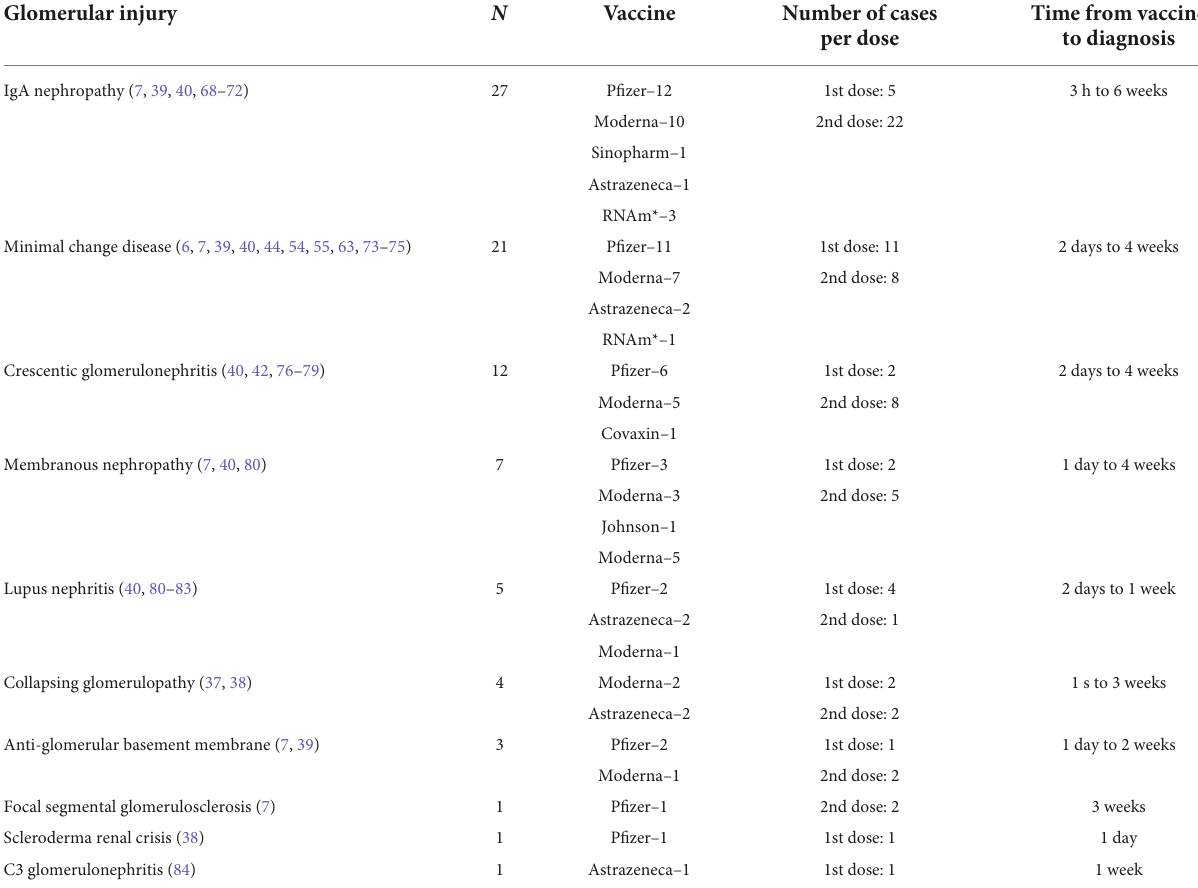
TABLE 2 Characteristics of post-vaccination COVID-19 kidney injury based on literature review ( n = 82). Glomerular injury N